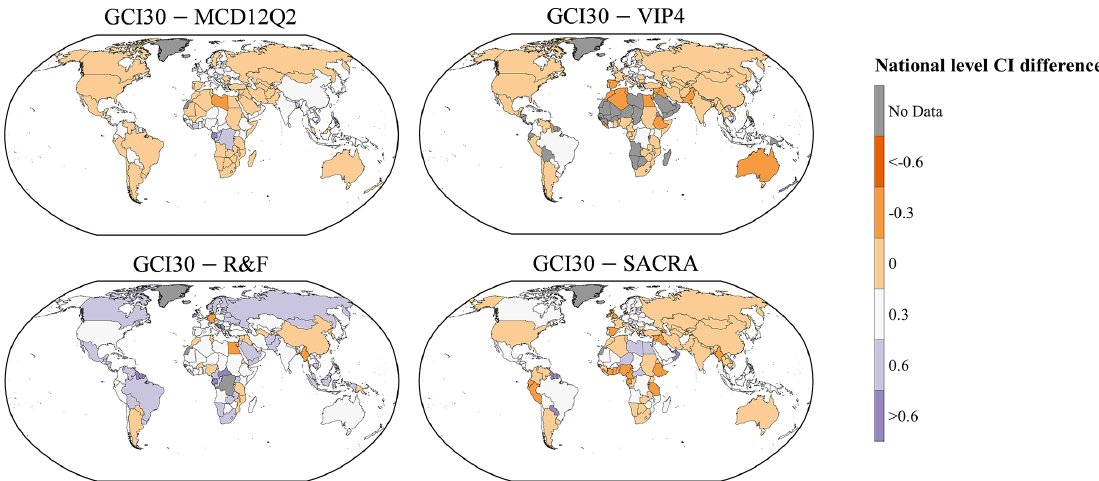
Figure 9. Statistics of annual CI differences at national level between GCI30 and four existing products. GCI30 − MCD12Q2 represents the differences between GCI30 and the “NumCycles” layer of MCD12Q2; GCI30 − VIP4 represents the differences between GCI30 and the “Number of Seasons” layer of VIP4; GCI30 − R&F represents the differences between GCI30 and harvest frequency by Ray and Foley (2013); GCI30 − SACRA represents the differences between GCI30 and CI by Kotsuki and Tanaka